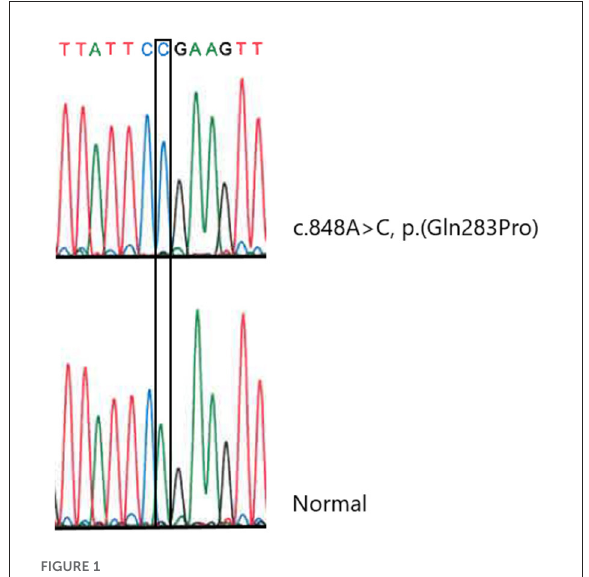
FIGURE1 Sanger sequencing confirming the SLC25A46 variant (NM_138773.3:c.848A > C,